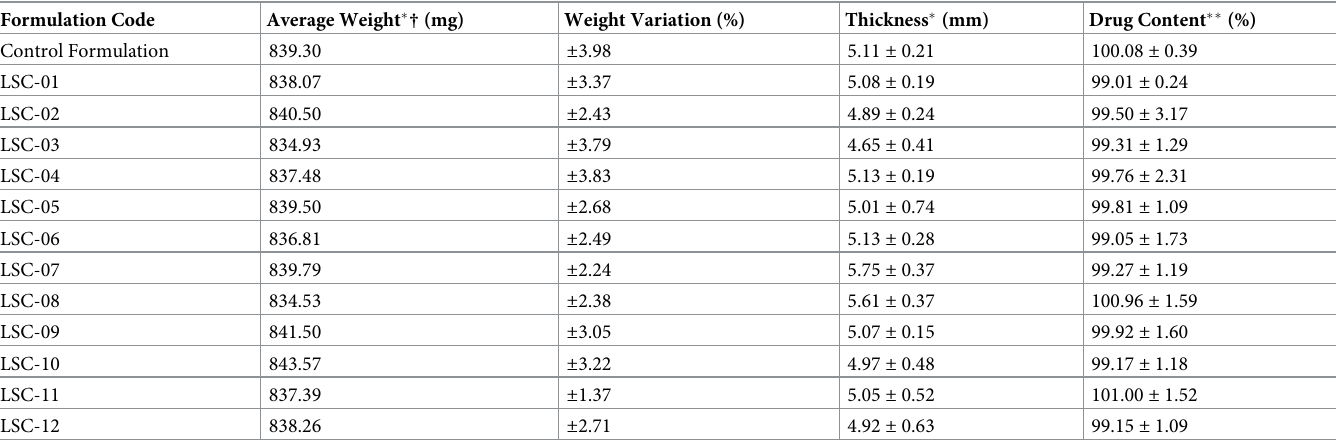
Table 5. Physical parameters of liquisolid compacts containing clopidogrel. Formulation